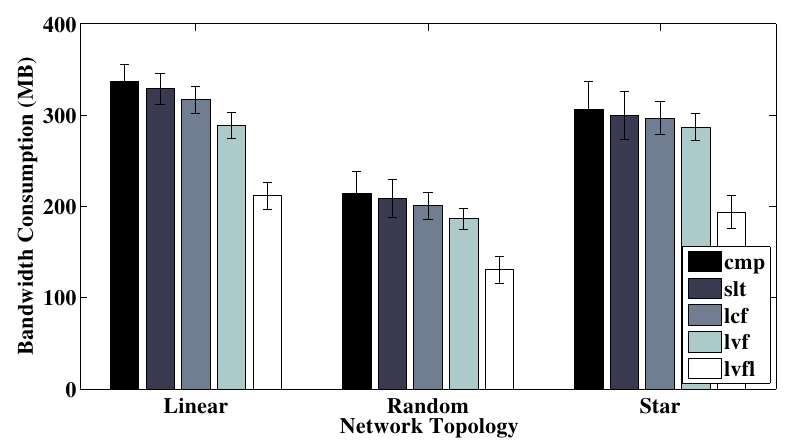
Figure 9. Different levels of queries’ localities.